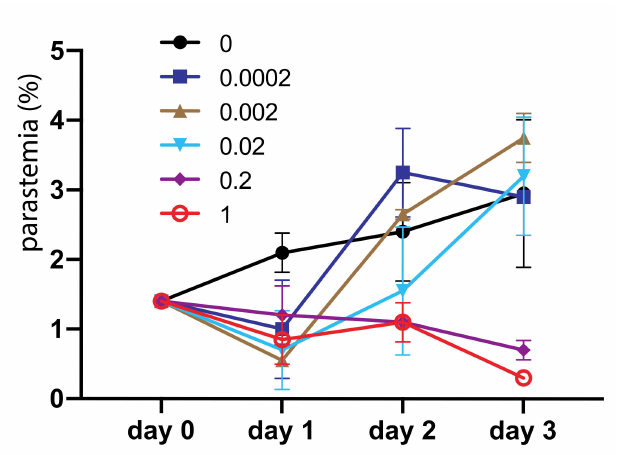
Figure 7. Asperaculane B inhibits the development of asexual stage P. falciparum , and the inhibition is